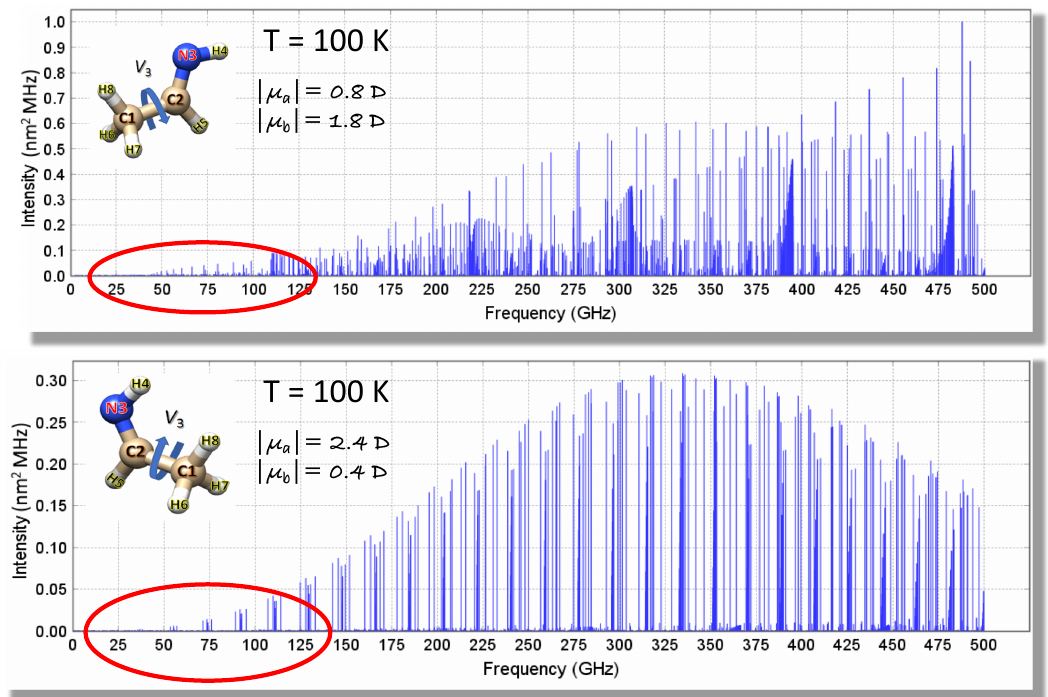
Figure 5. Simulation of the rotational spectra of E- (top panel) and Z-CH 3 CHNH (bottom panel) at T = 100 K obtained with the VMS-ROT software. The absolute values of the dipole moment components are also reported. The red circles highlight the frequency ranges for which measurements were available prior to the investigation of Reference